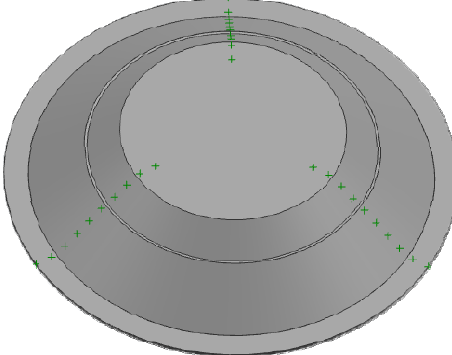
Figure 15. Sample position of residual stress detection.